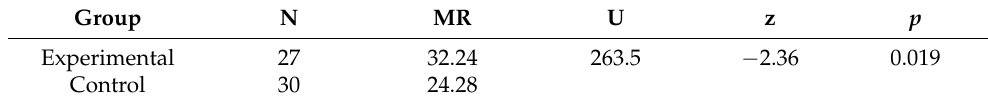
Table 5. Result of the Mann-Whitney U test of the SOLO scores of responses for EXPL.